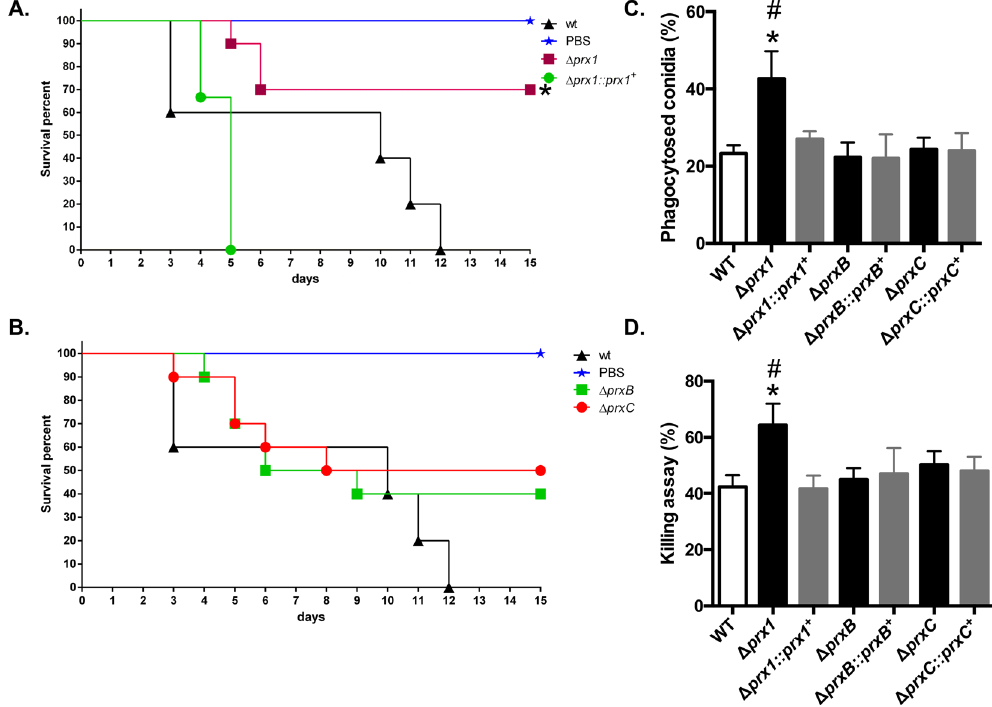
Figure 10. A . fumigatus Prx1, but not PrxB or PrxC contributes to virulence in a mouse model of invasive pulmonary aspergillosis. ( A , B ) Comparative analysis of wild-type and 1-Cys Prx mutant strains in a neutropenic murine model. No mock infected animals perished in either experiment. Survival of the mutant strain was compared to that of the wild-type and complemented strain. Infection experiments were repeated two times with similar results. Survival curves between the Δ prx1 mutant and wild-type strain and mutant and reconstituted strains were statistically significant ( * p ≤ 0.0132 and p ≤ 0.0074, respectively). No significant difference was observed between the wild-type and Δ prxB or Δ prxC deletion strains. Phagocytosis index ( C ) and killing activity ( D ) is increased in the A . fumigatus Δ prx1 mutant strain. The results are expressed as means ± SD for three independent experiments. * p ≤ 0.05 compared to wild-type; # p ≤ 0.05 compared to the complemented